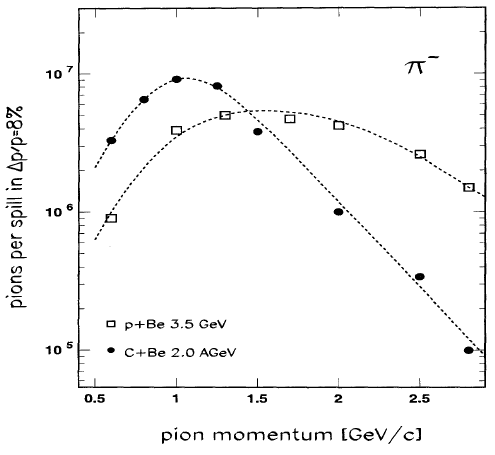
Figure 10. Negative pion yields at the HADES target point as a function of the momentum scaled to the space charge limit of